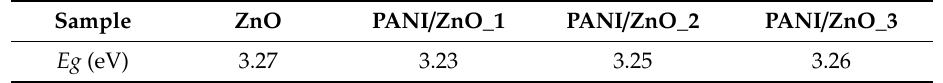
Figure 2. UV / VIS reflectance spectra of the PANI / ZnO photocatalysts. Figure 2. UV/VIS reflectance spectra of the PANI/ZnO photocatalysts. Table 1. ZnO bandgap ( E g ) determined from UV / Vis reflectance spectra of composite